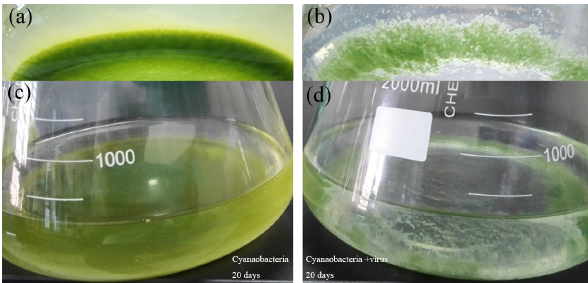
Figure 1. Photos of the culture medium at the end of the experi- ments. Without inoculation of the virus (a, c) . White precipitates are evident in viral lysis of cyanobacteria (b, d)